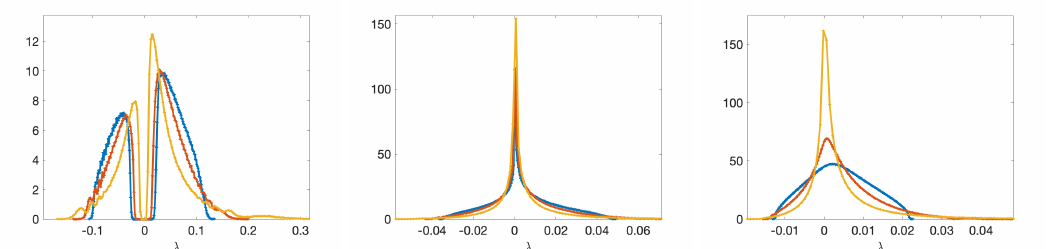
Figure 13 . The probability density functions for the negativity spectra at | β(cid:15) 0 | = 0 (blue), 1 (orange), and 1 (yellow). From left to right, we have N 2 is robust to finite temperature. We always take N